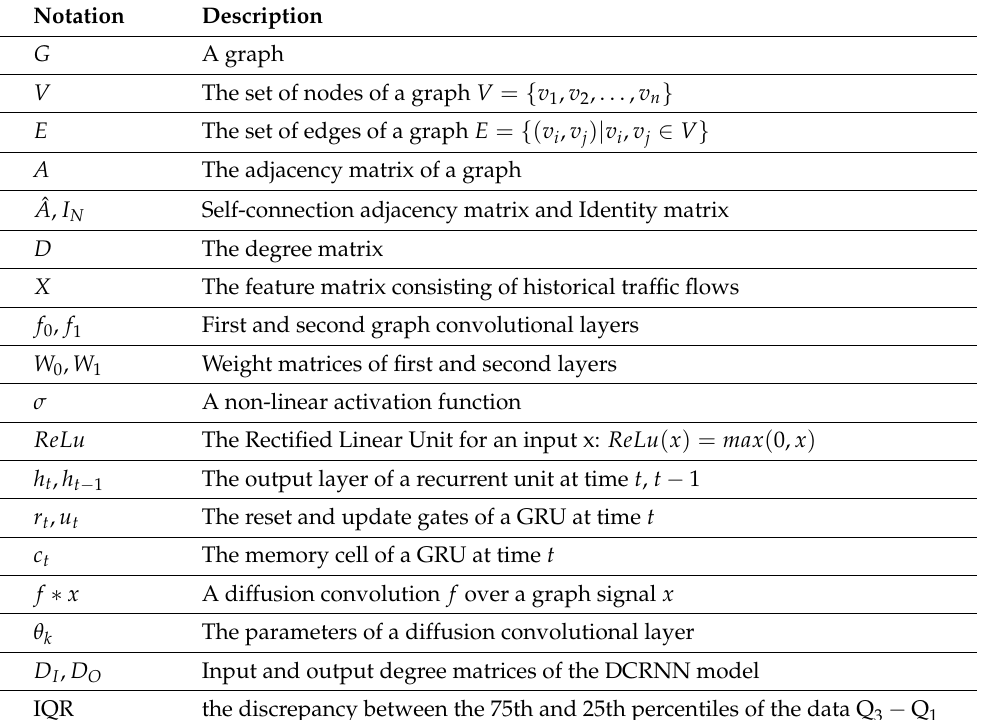
Table A1. Table of notations and symbols used in this